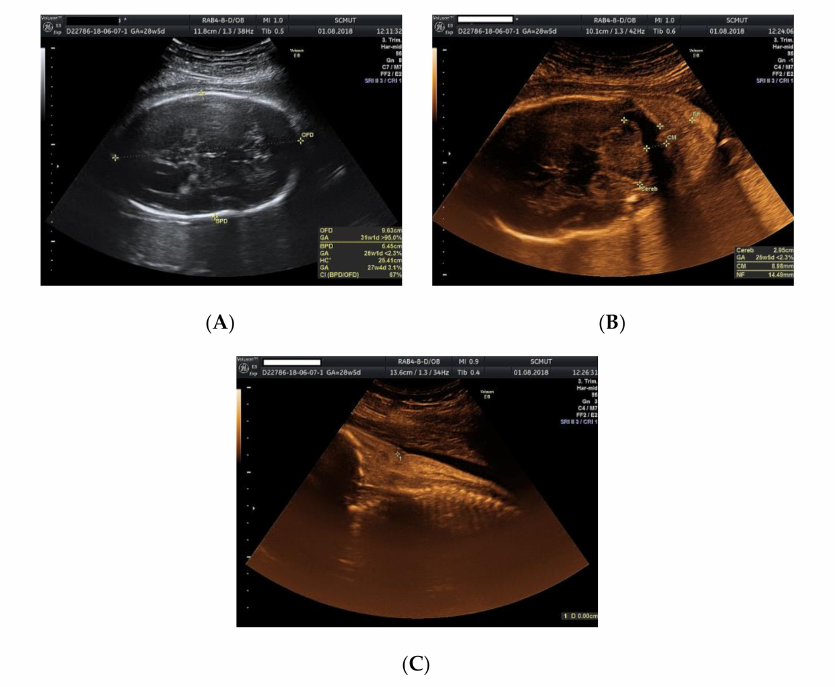
Figure 4. Ultrasound examination of the fetus: ( A ) dolichocephaly; ( B ) cerebellar hypoplasia; ( C ) increased nuchal